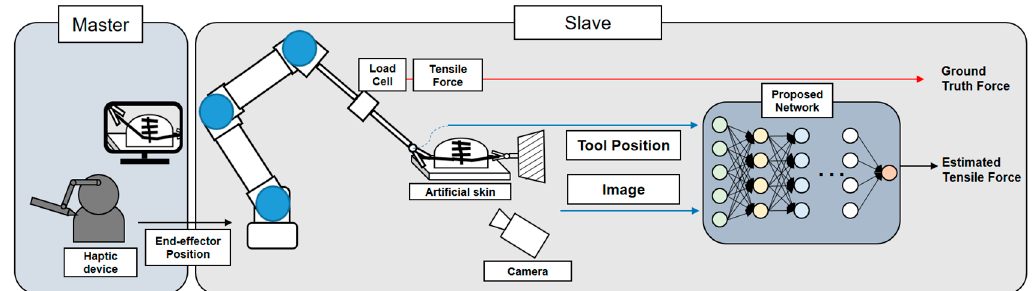
Figure 1. Robotic surgery experiment system for vision-based suture tensile force estimation. Simplified procedure of the proposed method and its experiments. An operator controlled the robot with visual information by sending the position of the end-effector. On the tool, there is a load cell that measures the ground truth of the tensile force. The force was estimated from the image and tool positions using the proposed network.